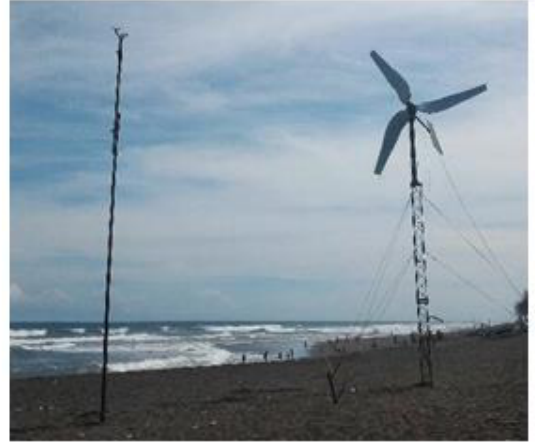
Figure 6. Field measurement set-up [54].